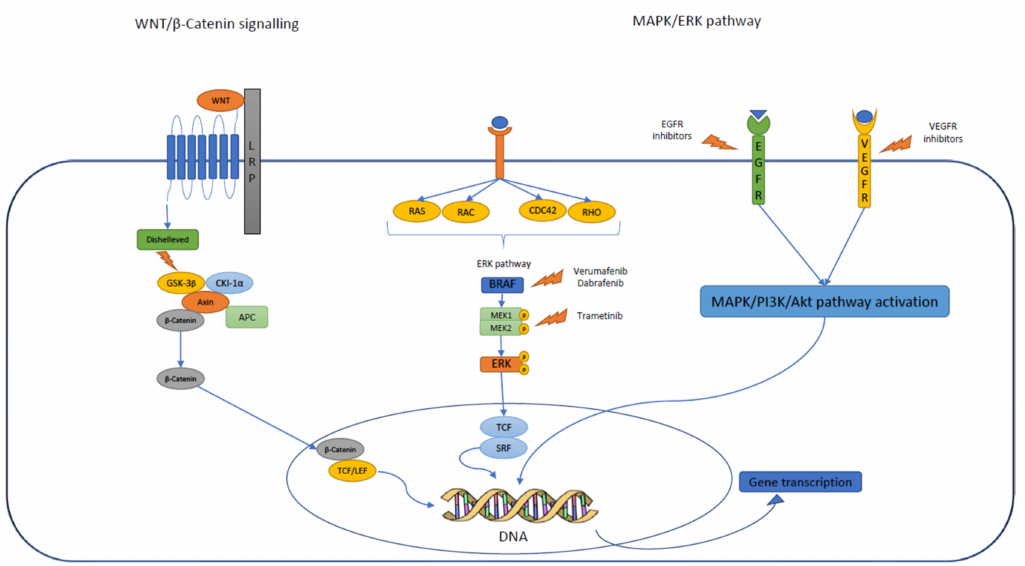
Figure 3. Molecular pathways involved in CP development and potential target